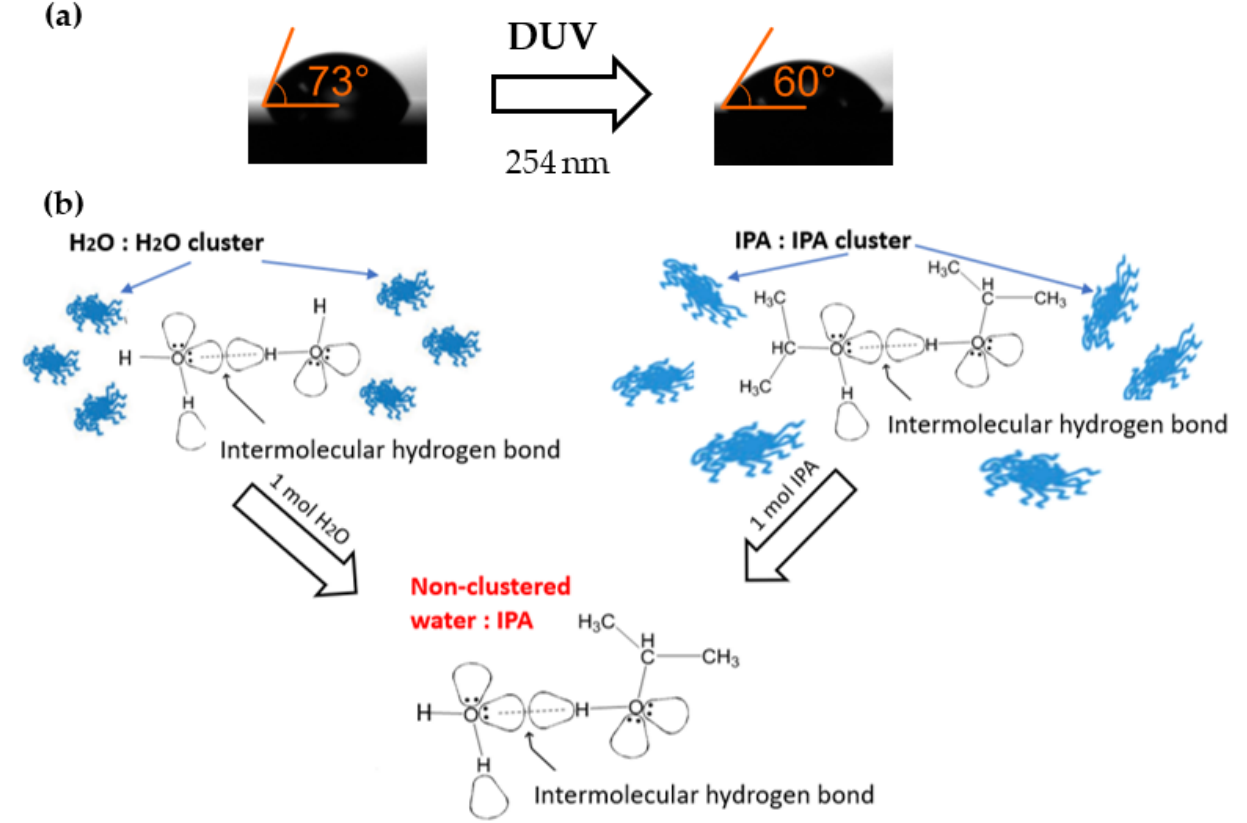
Figure 3. ( a ) Water contact angle on PMMA before (left) and after (right) DUV exposure. Increased hydrophilicity observation corresponds to increasing polarity of new chemical products received after DUV exposure of PMMA. ( b ) Schematic representation of reconstruction of water: water and IPA: IPA clusters into non-clustered water: IPA mixture to act as an effective solvent, where under specific water: IPA mixture due to formation of hydrogen bonds connect effectively to the polymer.